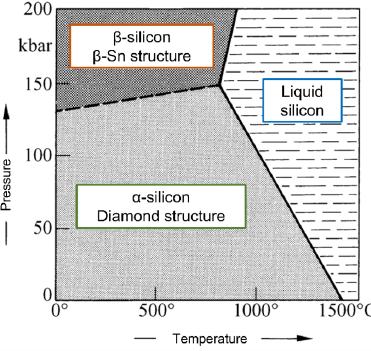
Figure 1. States of silicon with dependence on pressure and temperature, adapted with permission from Ref. [1].